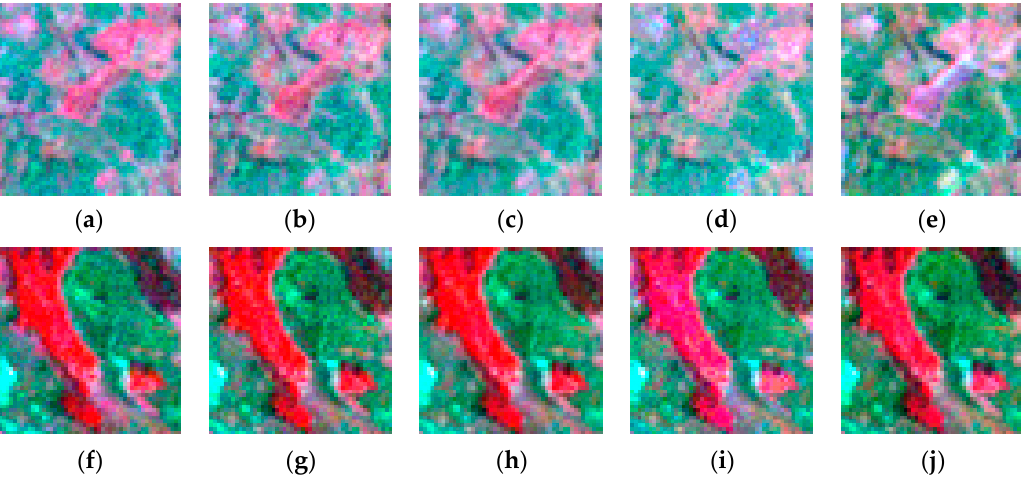
Figure 4. Zoomed-in images of the upper-right box ( top row ) and lower-left box ( bottom row ) marked in Figure 3a corresponding to the images in Figure 3a–e.